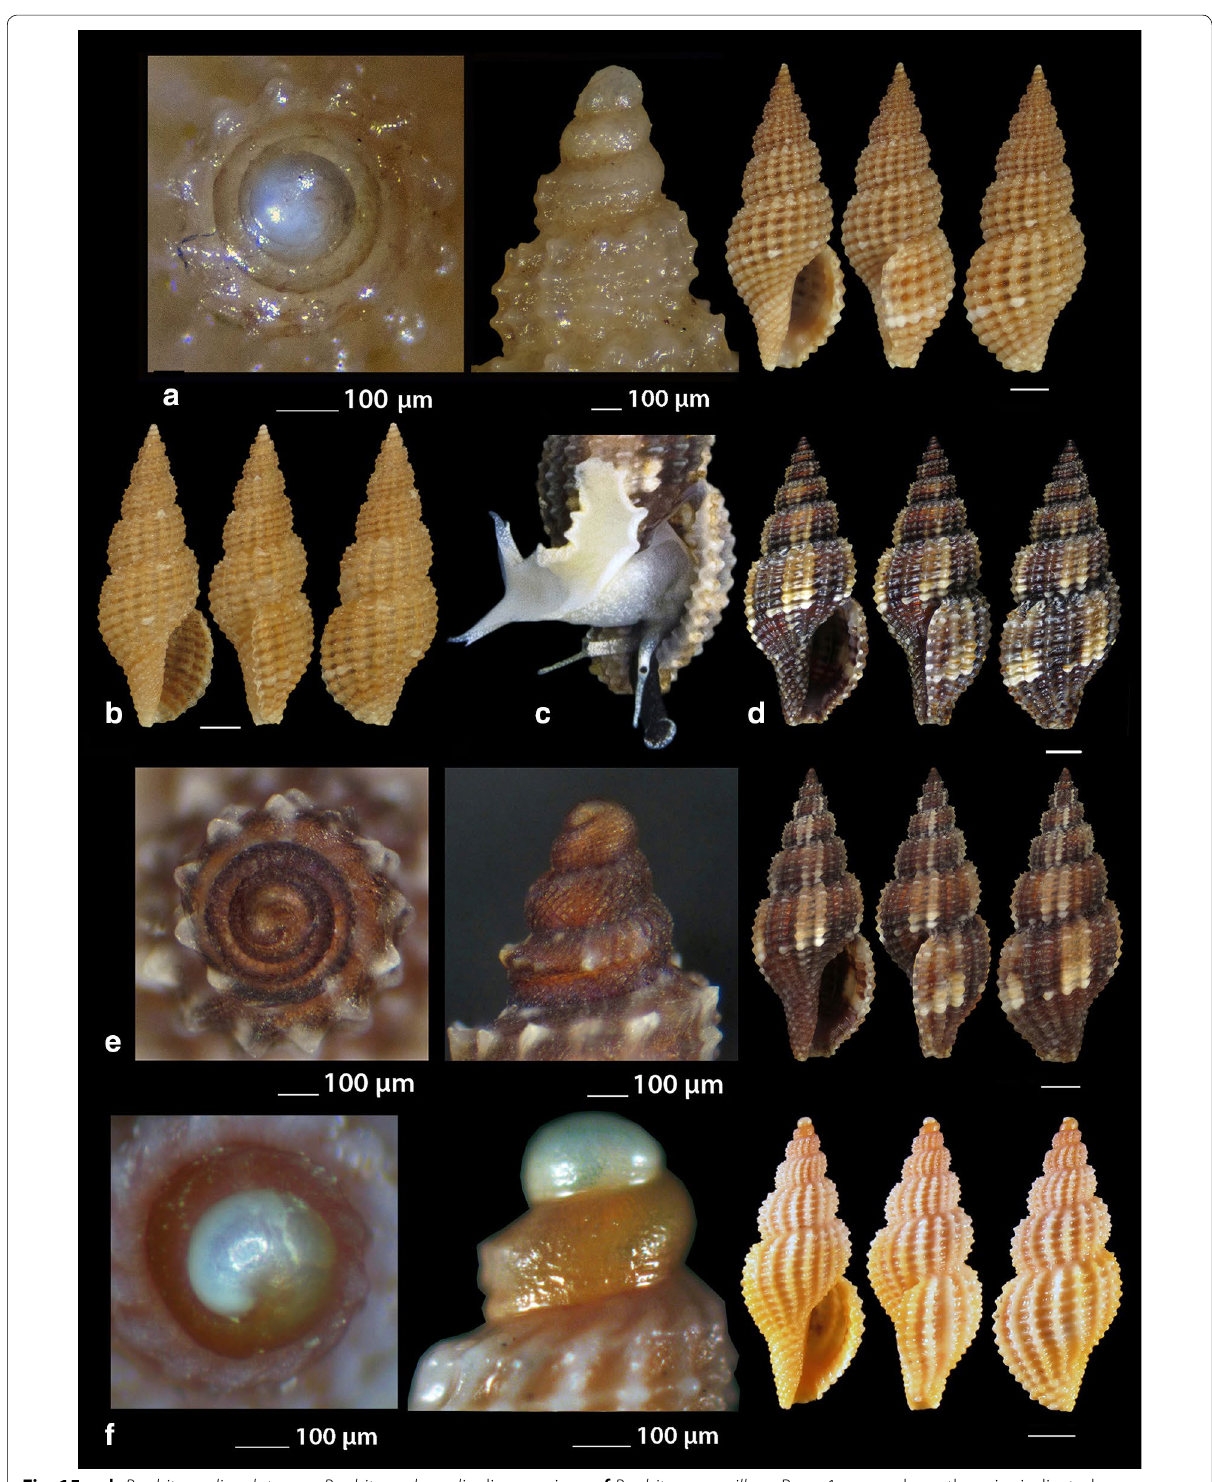
Fig. 15 a , b Raphitoma lineolata . c – e Raphitoma locardi , c live specimen. f Raphitoma papillosa . Bar